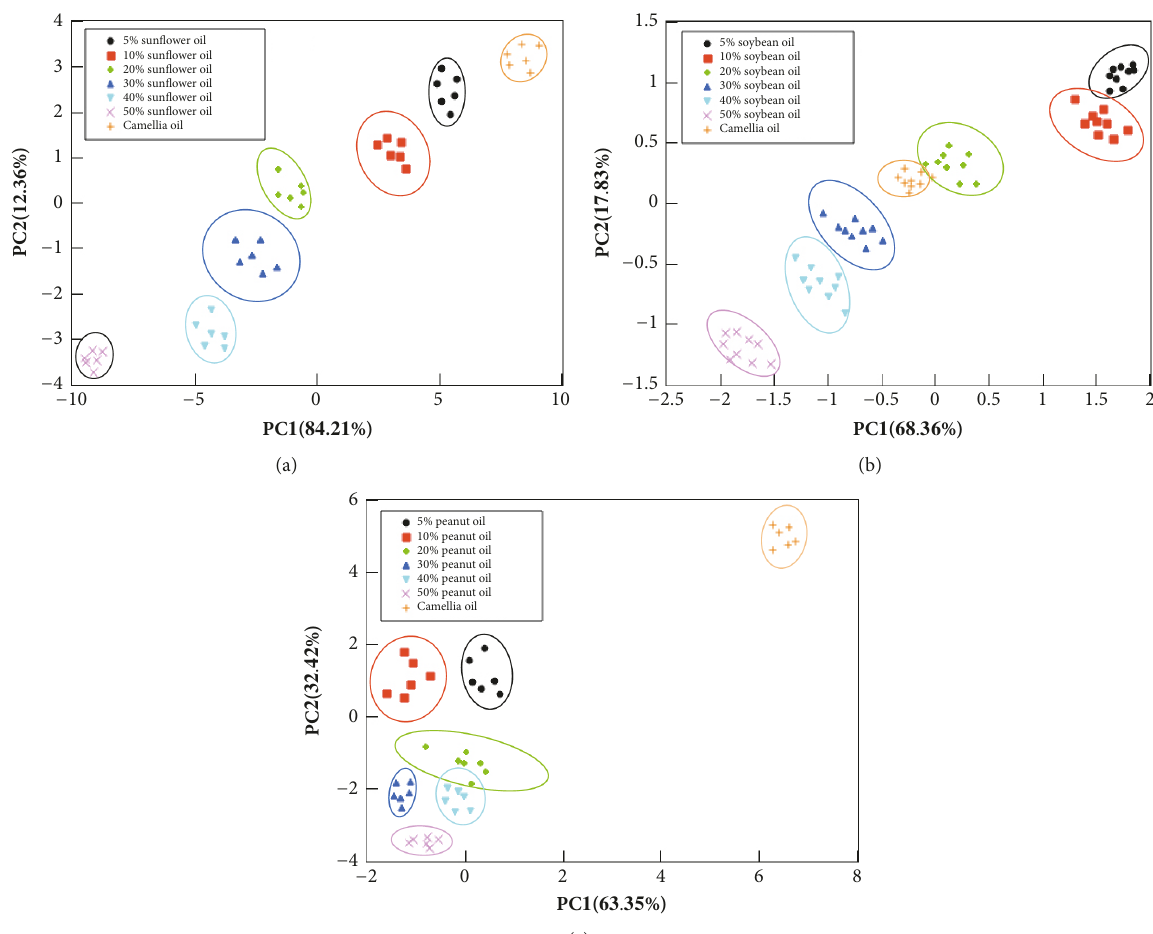
Figure 4: PC1 and PC2 scores of pure canola oil adulterated with (a) sunflower oil, (b) soybean oil, and (c) peanut oil.